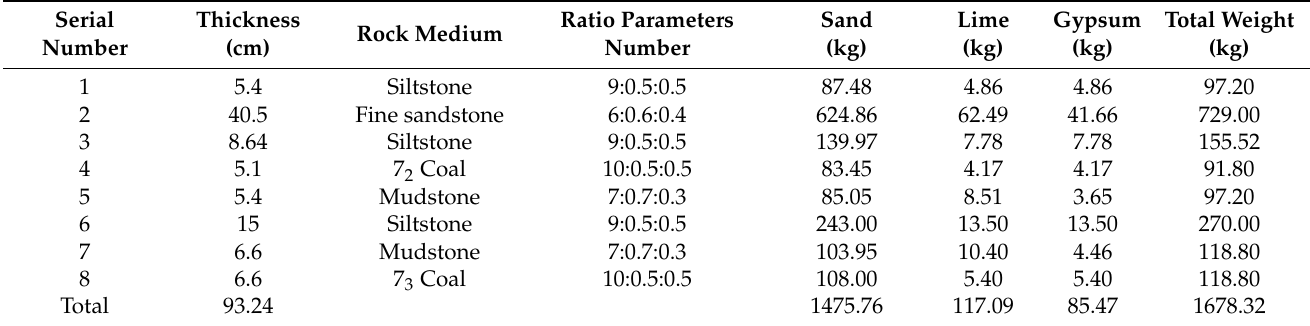
Table 4. Ratio parameters of the materials in blasting tests.